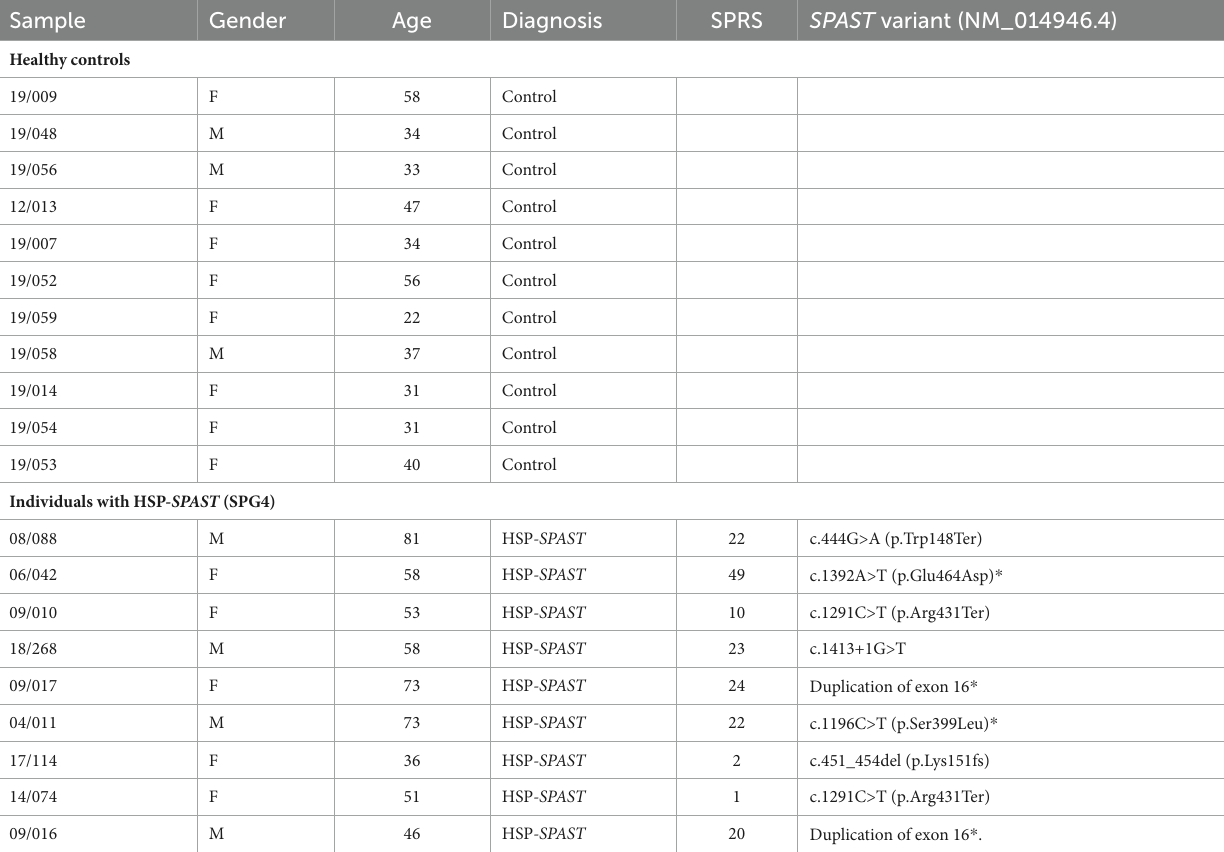
TABLE 1 Details of individuals with HSP- SPAST ( SPG4 ) and healthy controls.